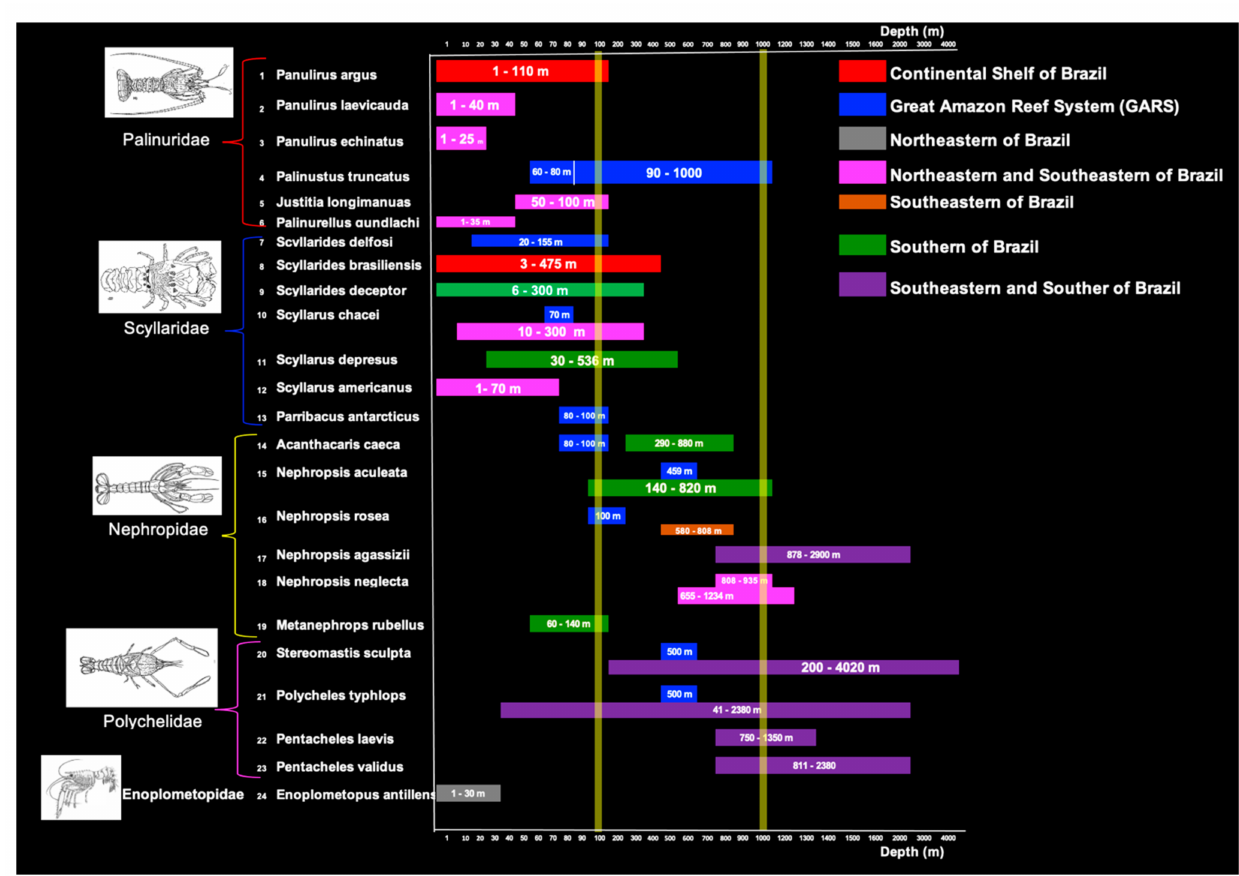
Figure 4. Bathymetric distribution of lobster species according to sector of continental shelf of Brazil